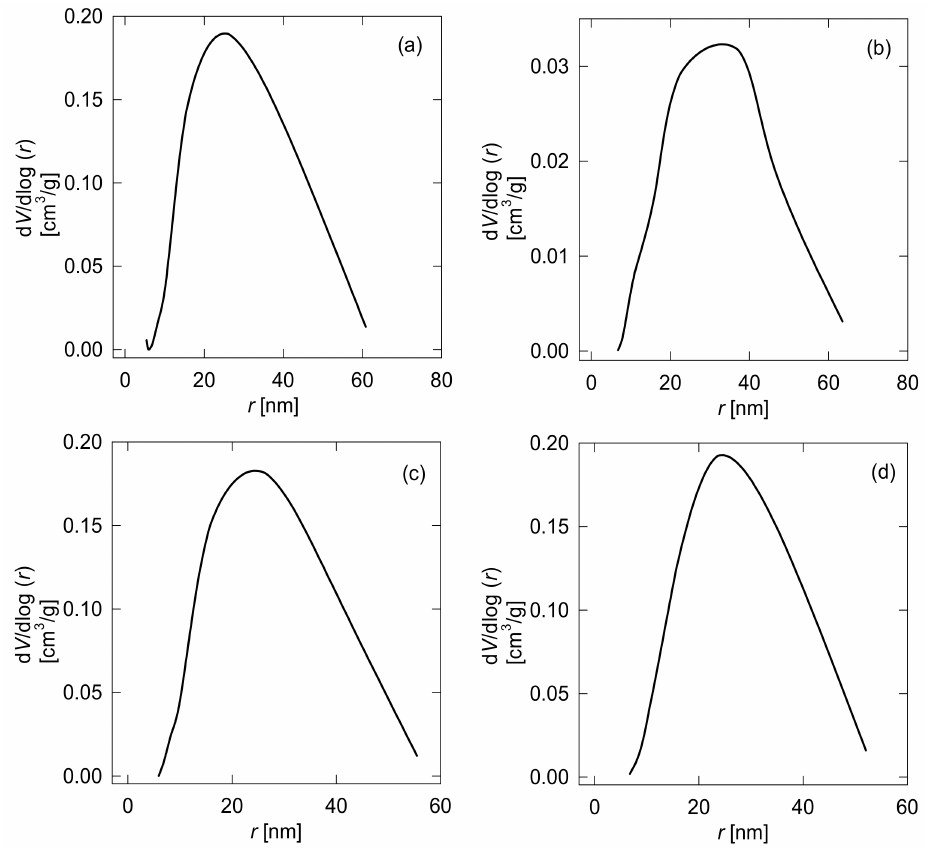
Figure 5. BJH curves for pore distribution visualization of ( a ) bare PDMS, ( b ) GMA-DMAEMA 10, ( c ) GMA-DMAEMA 5, and ( d ) MMA-DMAEMA 10 membranes.